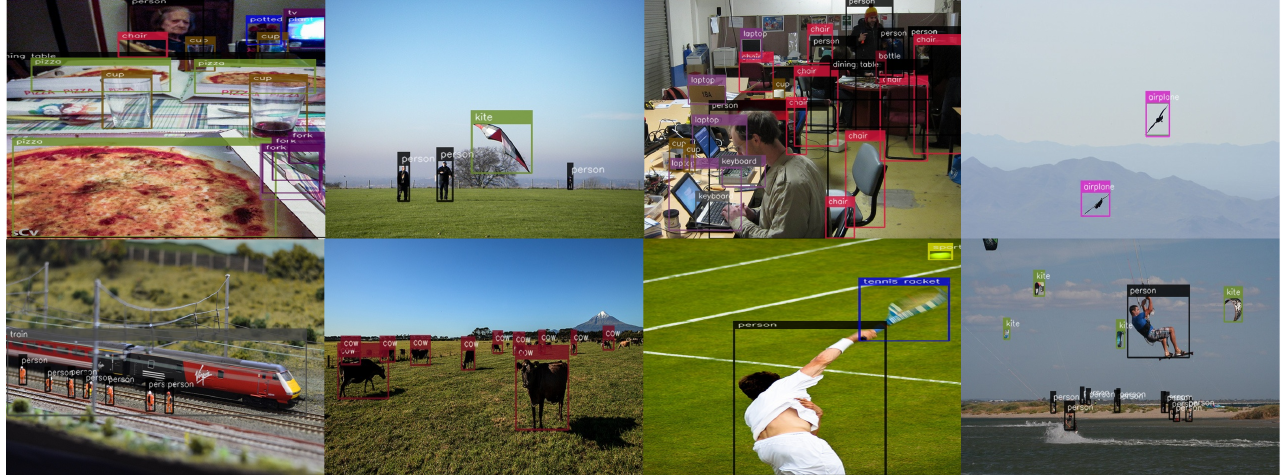
Figure 7. Detection results of the MS COCO2017 minival data set. The network used in the experiment uses an input resolution of 512 × 512, and EfficientNet-B0 is used as the backbone network. (Number of classification classes: 80).